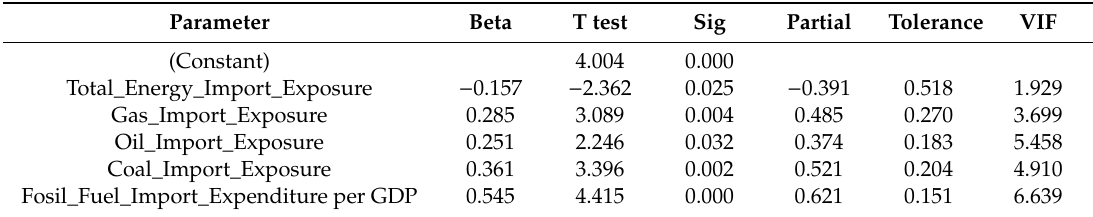
Table 6. Multicollinearity and partial correlation of parameters from the Fuel Imports group.